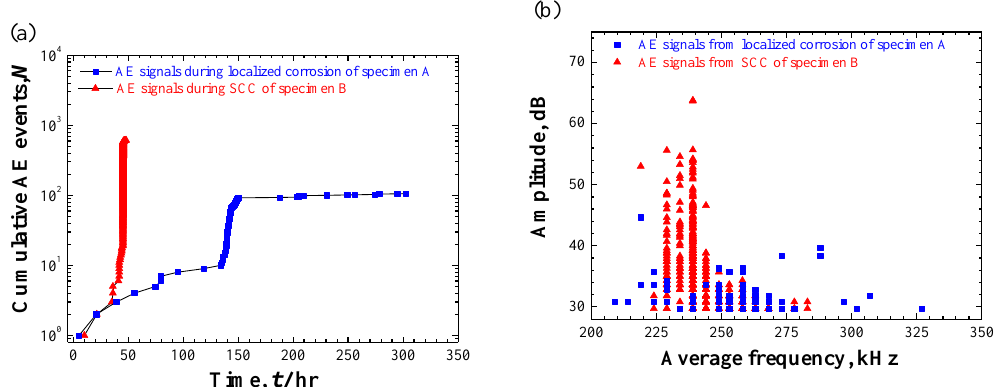
Figure 10. Comparison of the AE signals extracted from the corrosion processes of specimens A and B: ( a ) Cumulative AE events over time; ( b ) Cross-plot of amplitude to average frequency. Online version in color.